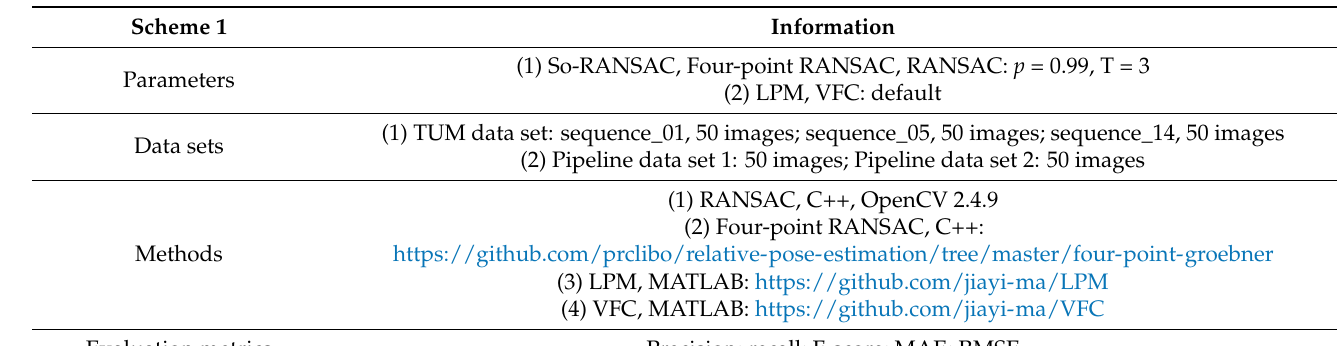
Table 2. The details of the experimental settings.